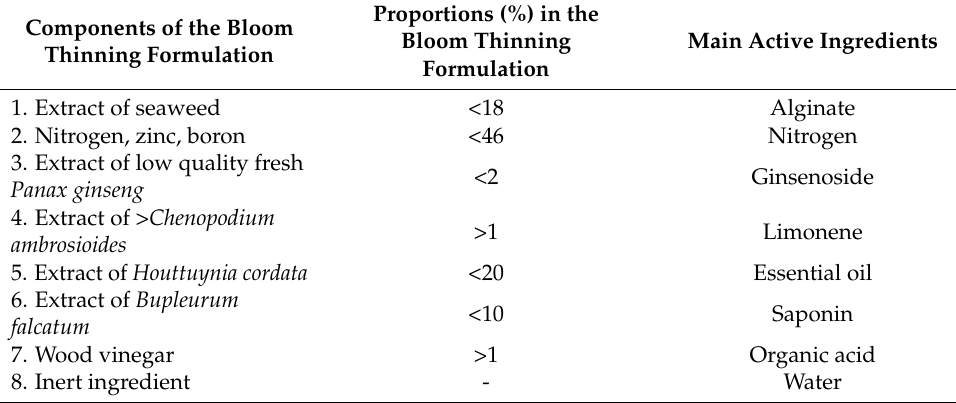
Table 1. Major components of the bloom thinning formulation. Components of the